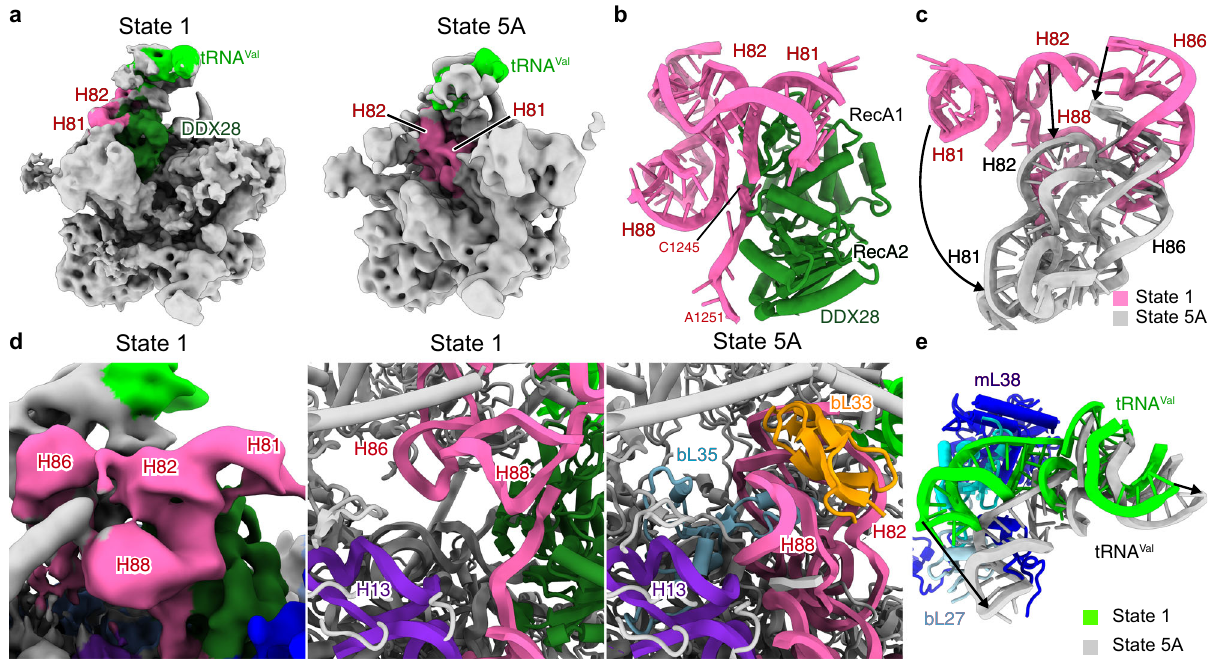
Fig. 2 The immature central protuberance and DDX28 helicase in state 1. a Overall positions of H80 – 88 of domain V of the 16S rRNA and DDX28. b DDX28 interacts with nucleotides 1245 – 1251 of domain V of the 16S rRNA. c Repositioning of H80 – 88 between state 1(pink) and 5A (gray). d Density showing void between H82 and H88 in state 1 (left), and models of state 1 and 5A showing incorporation of bL33 and bL35. e Comparison between state 5A and state 1, highlighting an immature conformation of the valine tRNA in the central protuberance of state